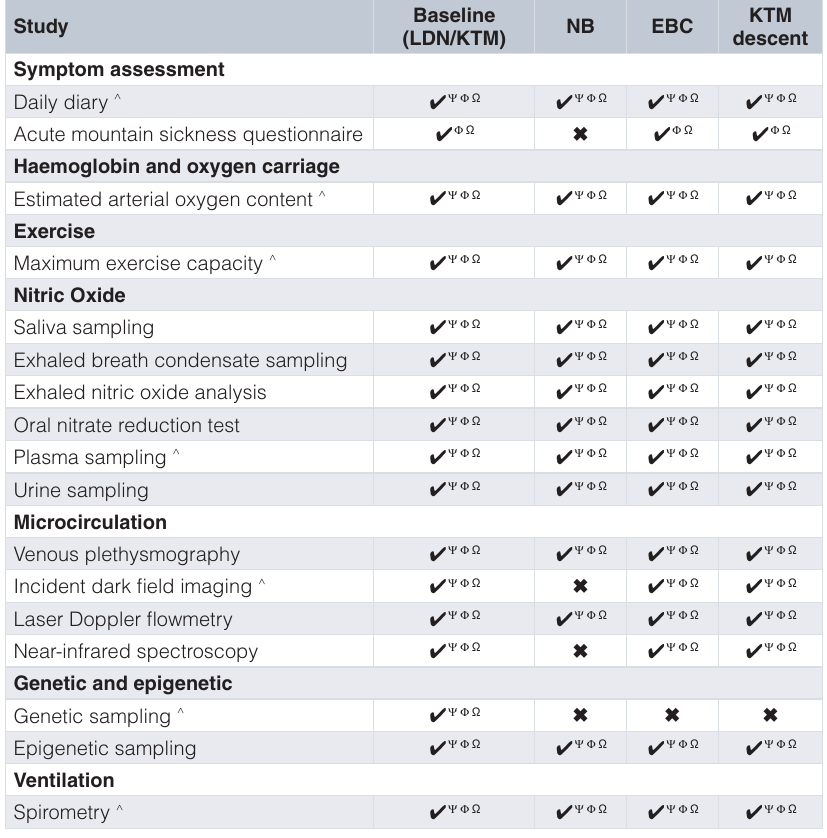
Table 3. Core studies conducted on XE2, highlighting at which lab and in which